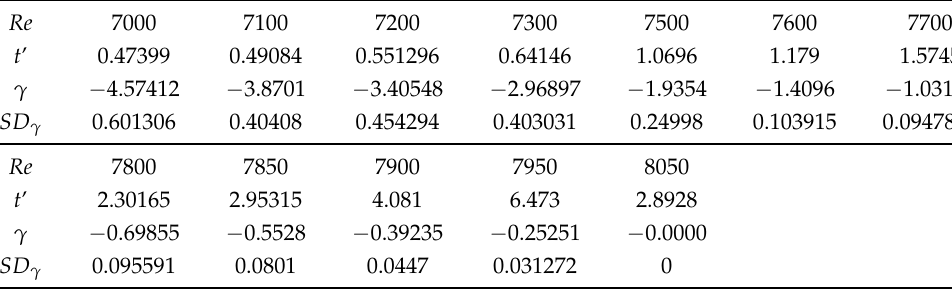
Table 2. Evolution of growth rate decay with Reynolds